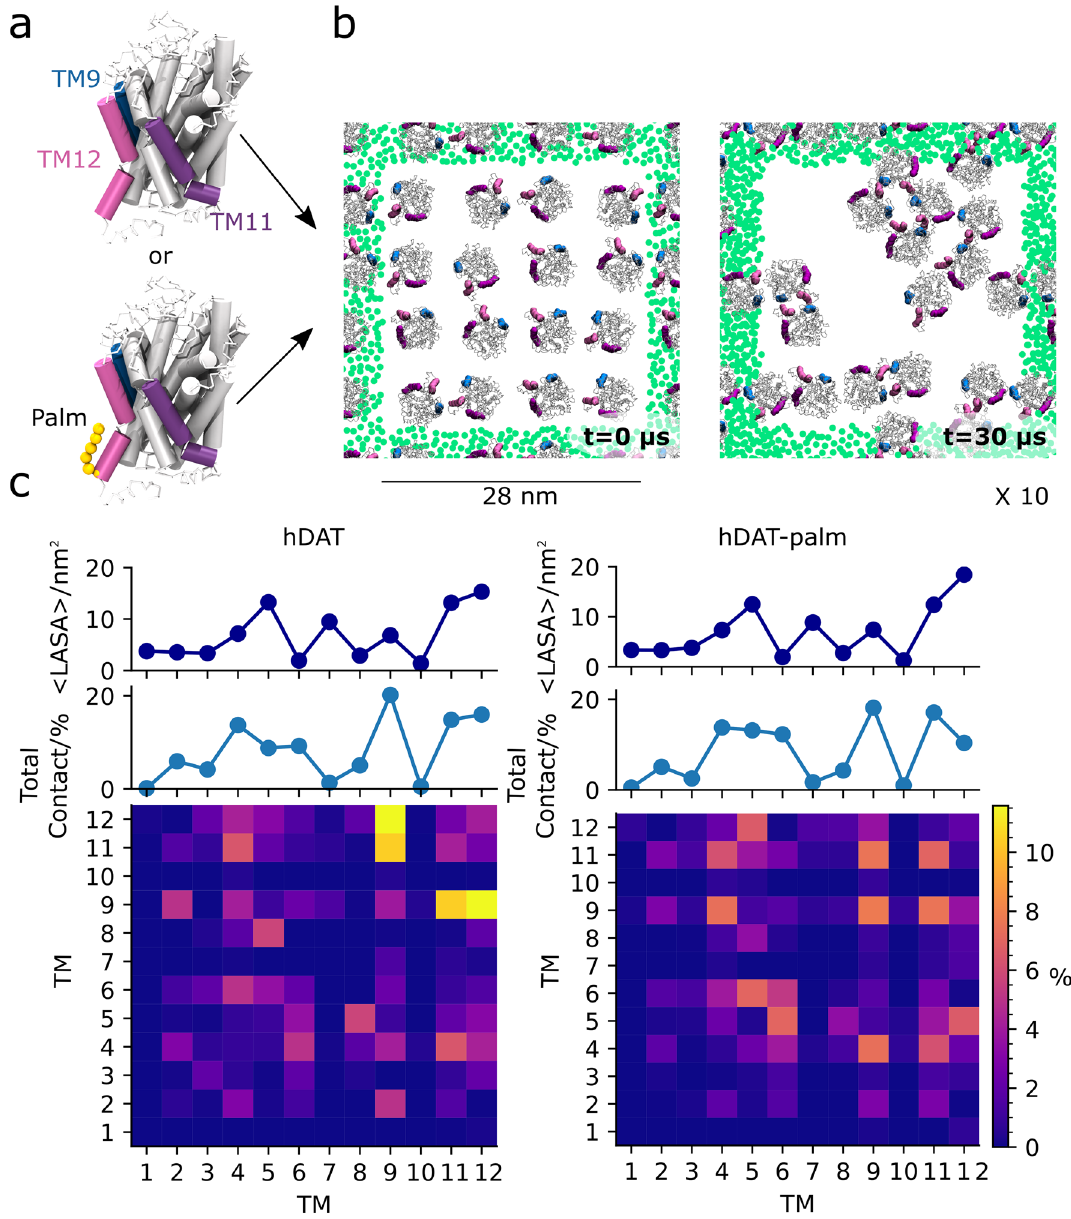
Figure 1. System setup and interhelical contact maps of hDAT and hDAT-palm excluding the palmitoyl group. ( a ) The hDAT CG structures with and without a palm group (orange spheres) attached to TM12. Shown in ( b ) is a top view of one of a system a(top view with respect to the membrane) at 0 µs (left) and after a 30 µs simulation (right). In the two systems 16 hDAT and hDAT-palm molecules were initially equally spaced and randomly orientated with respect to each other in a pure POPC membrane. hDAT and hDAT-palm were simulated for 30 µs and repeated 10 times. Palm, TM9, TM11, and TM12 are highlighted in orange, blue, purple, and magenta, respectively. The green dots represent the GL1 bead of POPC in the nearest periodic images for the system. Illustrated in ( c ), hDAT (left) and hDAT-palm (right), are the per helix contact maps calculated for all possible dimer pairs. An interhelical contact was considered when any residue in one protomer’s helix was within 7 Å of any residue in the other protomer’s helix (not considering the palm group). The contacts have been normalized by the total number of contacts calculated for the hDAT system. The 1D plot immediately above the contact map illustrates the sum of all TM contacts calculated for each helix given in %. The top 1D plot illustrates the average lipid accessible surface area in nm 2 of the different helices in the two systems using a probe of size 0.26 nm. The standard deviations are not visible in the plots due to their small sizes (they vary between 0.23 and